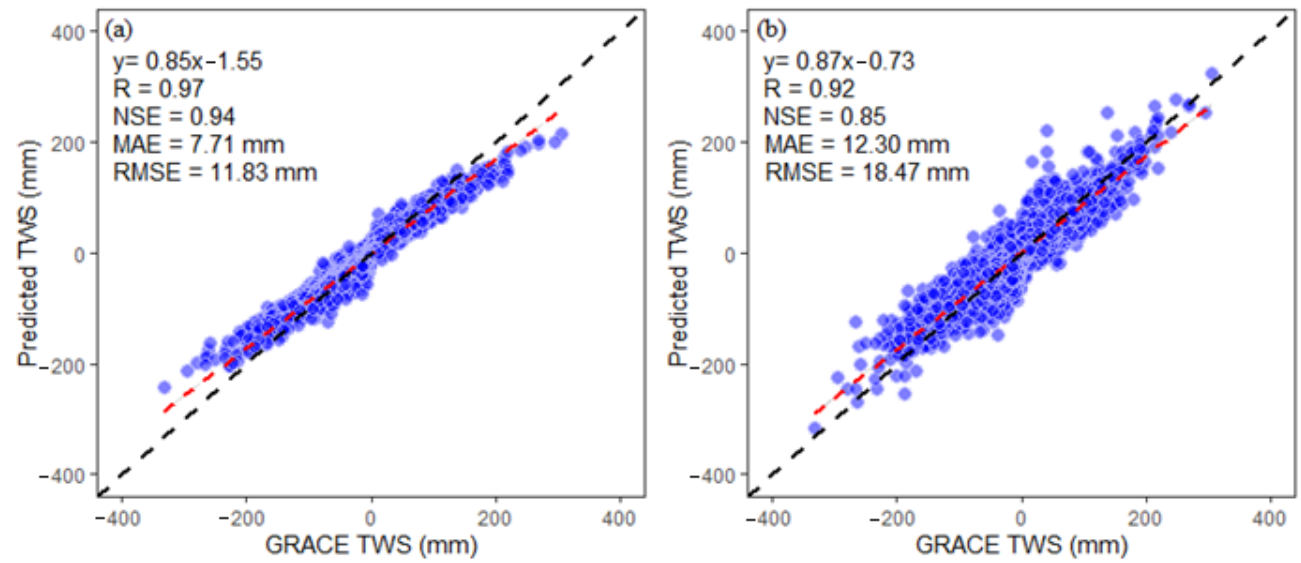
Figure 6. Accuracy assessment of machine-learning models ( a ) RFM and ( b ) ANN with GRACE-derived TWS.